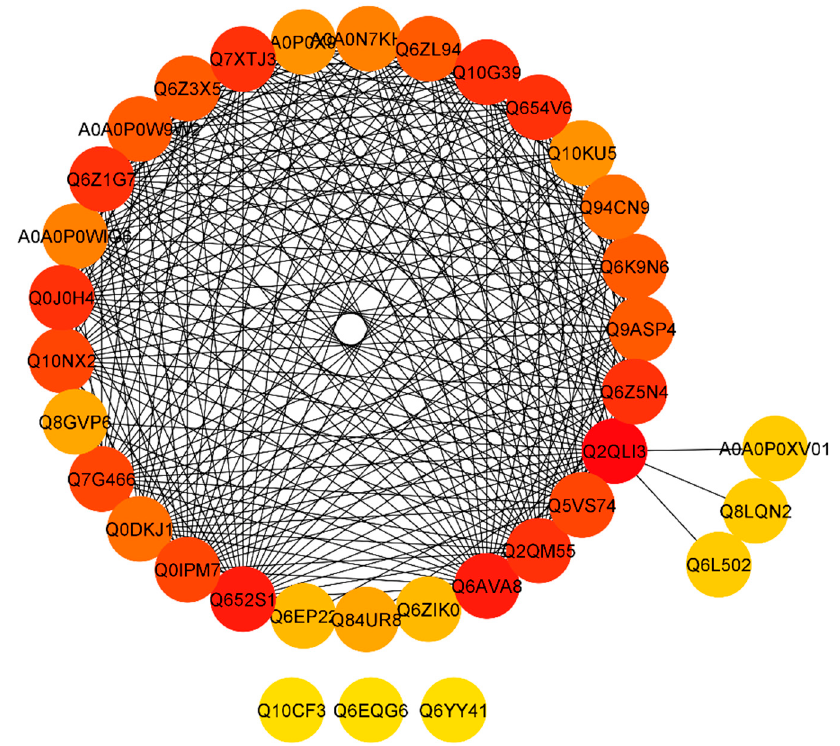
Figure 6. STRING software predicted protein to the protein network of differentially expressed proteins (DEPs). Differentially accumulated proteins are represented by a node, whereas the different color of lines represents evidence for the predicted functional relationship. The strong interaction is indicated by redder color. The proteins outside the circle showed no or weak interaction.